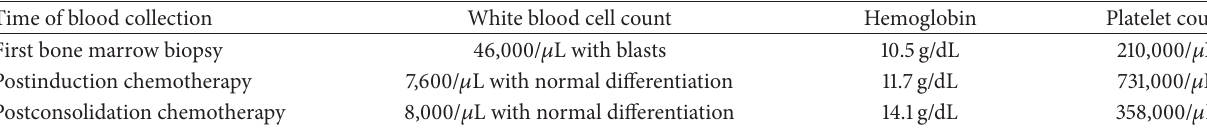
Table 1: Pertinent peripheral blood findings.